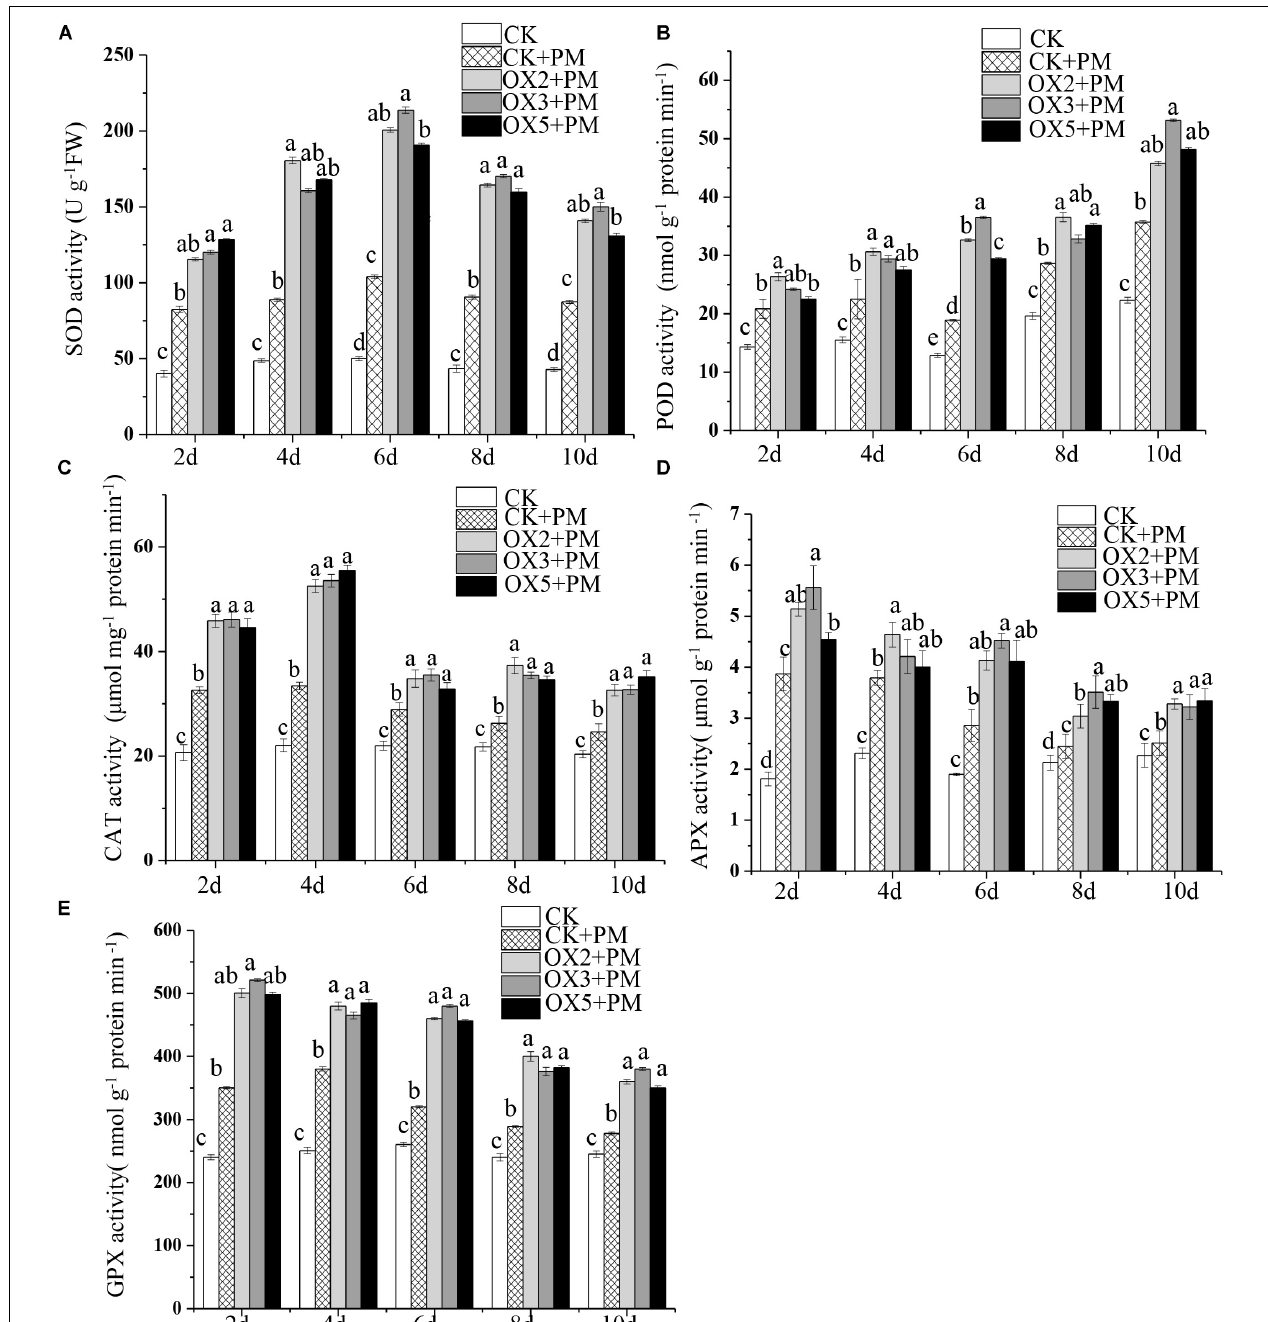
FIGURE 9 | Activity of antioxidant enzymes in CsHMGB -overexpressing (OX) leaves of “D9320” plants. (A) SOD activity. (B) POD activity. (C) CAT activity. (D) APX activity. (E) GPX activity. Data are the means of three replicates with SEs, and different letters indicate a significant difference ( p < 0.05 by Tukey’s test).